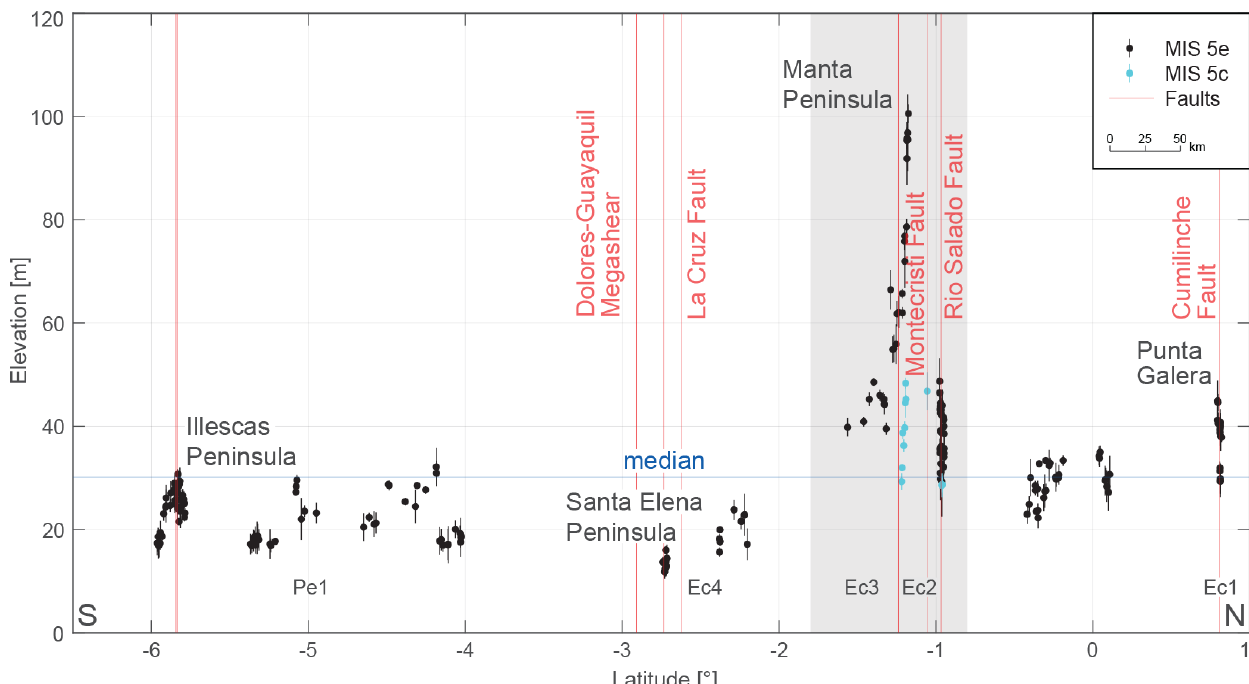
Figure 6. Measured shoreline-angle elevations of MIS 5e and 5c in Ecuador (Ec) and northern Peru (Pe). A high and inferred long-wavelength change in terrace elevation occurs at the Manta Peninsula (gray area) and at low elevations farther south at the Santa Elena Peninsula. Several terrace-elevation changes over short distances coincide with faulting at Punta Galera and on the Illescas Peninsula. Median elevation: 30.1m. For location see Fig.